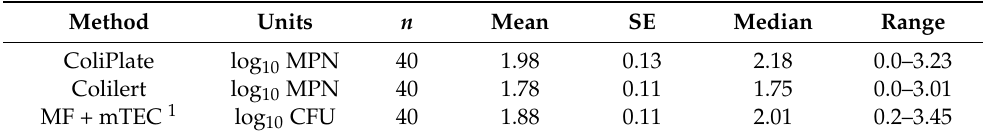
Table 1. Descriptive statistics describing the distribution of E. coli density results obtained from the 40 natural water samples evaluated in this study for method